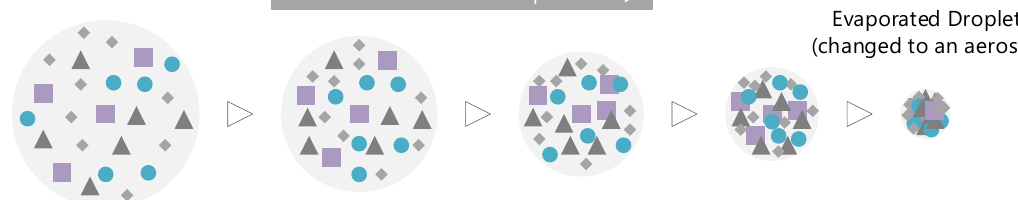
Figure 2. Evaporation of a human exhaled droplet in the liquid phase to a non-evaporative aerosol containing viruses. Any movement of the air may carry indoor floating aerosols. Airstreams are created simply from the air temperature differences, even from human body heat. In the same way, other mechanical and electrical devices, including fans, televisions, and medical equipment, can disturb patients’ nearby airflows and move the viruses in a closed room.